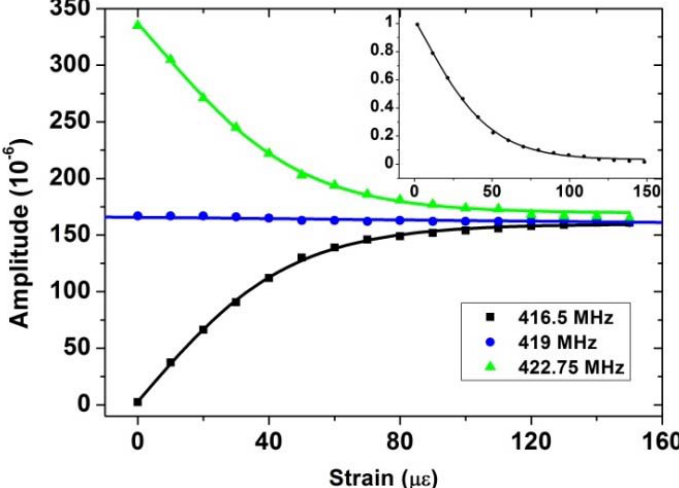
Figure 20. The measured amplitudes of the RF signal as the applied strain varies. The inset shows the normalized peak-dip intensity difference of the output RF signal power as the applied strain